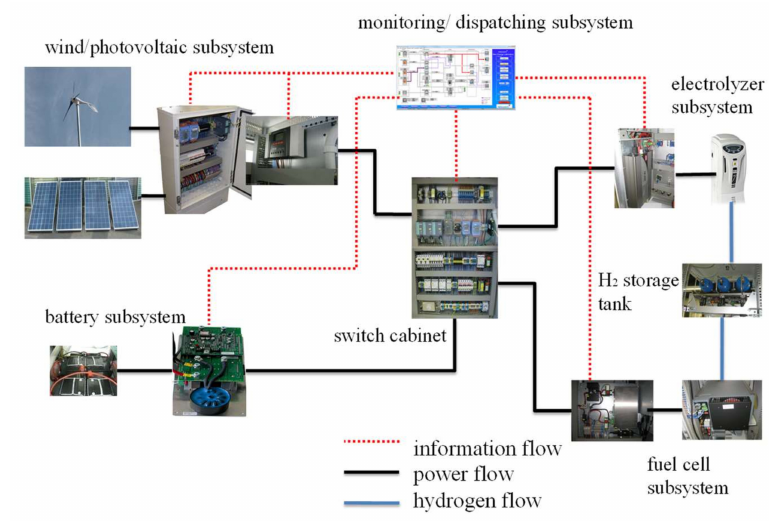
Figure 3. Multi-energy system structure.